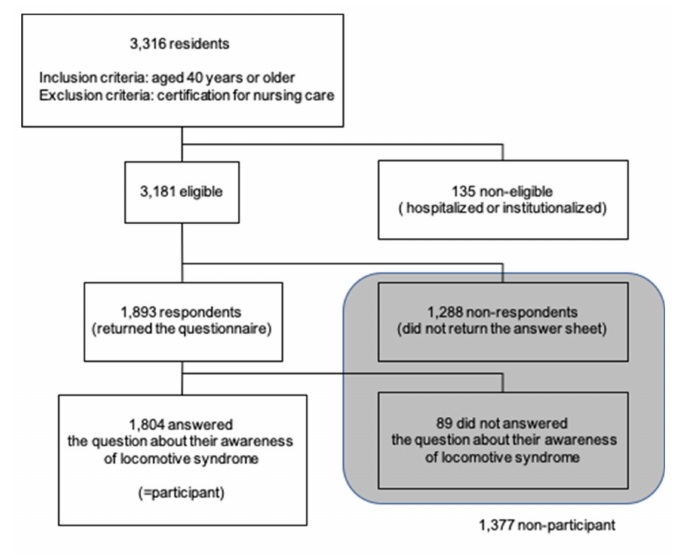
Figure 1. Schema of the recruitment of the